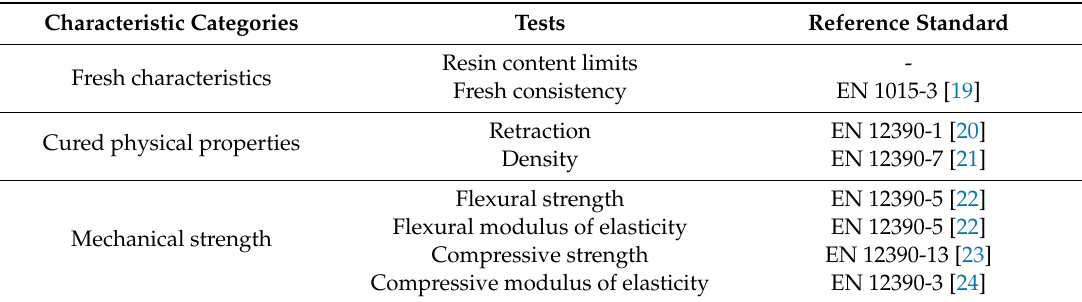
Table 3. Laboratory investigation